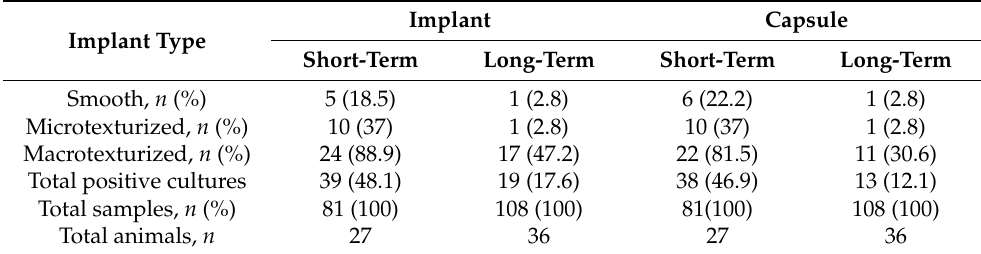
Table 1. Implant-associated infection rate according to implant